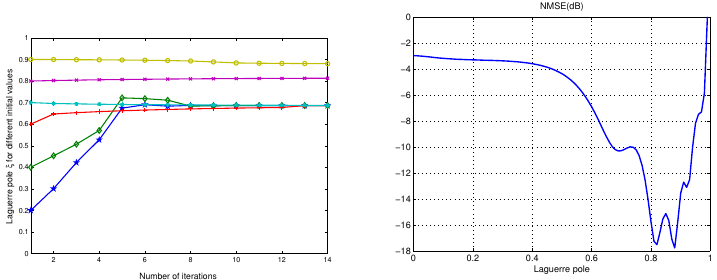
Figure 4. Identification of Laguerre